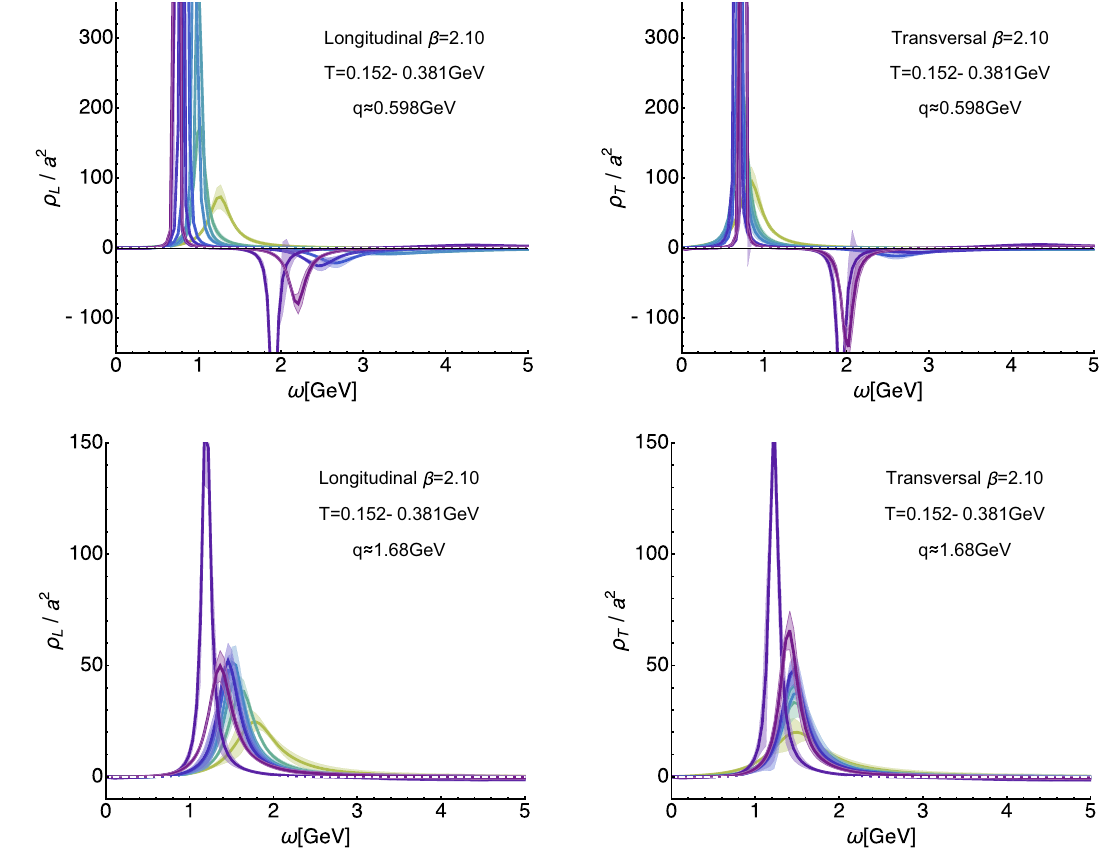
Fig. 10 In-medium longitudinal (left) and transversal (right) gluon spectral functions at β = 2 . 10 at the lowest available spatial momentum q ≈ 0 . 6 GeV (top) and at intermediate q ≈ 1 . 68 GeV (bottom) evaluated in the temperature range T = 0 . 152 ... 0 . 381